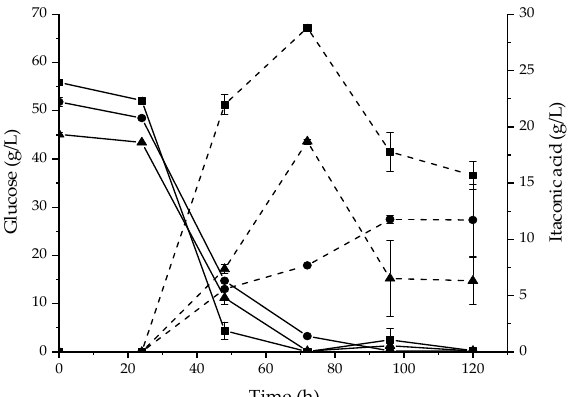
Figure 2. Glucose (solid lines) and itaconic acid (dashed lines) concentrations during the fermentation of the cellulose pulp hydrolysate sterilized by di ff erent methods. Membrane filter 0.2 µ m ( (cid:4) ); autoclave at 112 ◦ C ( • ); and autoclave at 121 ◦ C ( (cid:78) ). All the hydrolysates were supplemented with nutrients to be used as fermentation medium.